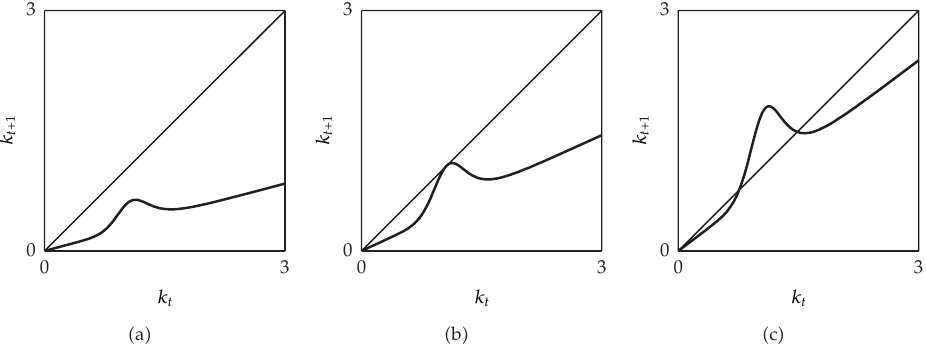
Figure 2: Map F and its fixed points in the case of non-invertibility for the following parameter values: β (cid:7) 0 . 5, s w (cid:7) 0 . 2, s r (cid:7) 1, p (cid:7) 8, δ (cid:7) 0 . 2, α (cid:7) 0 . 3. In (cid:3) b (cid:6) n (cid:7) n (cid:7) 0 . 7444; in (cid:3) a (cid:6) n > n , in (cid:3) c (cid:6) n < n